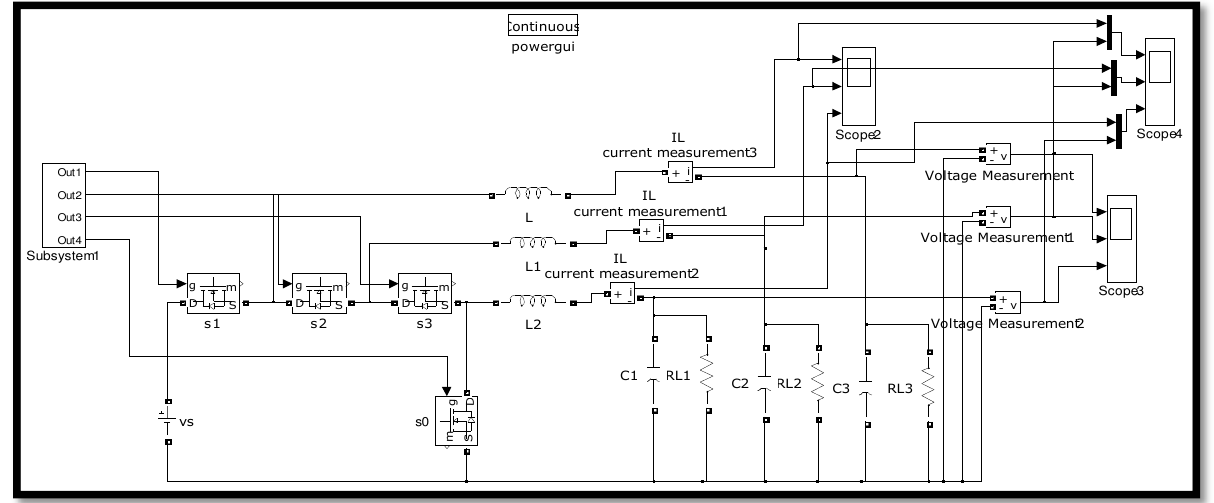
Fig. 11. Buck Converter Simulink (Multiple Outputs).